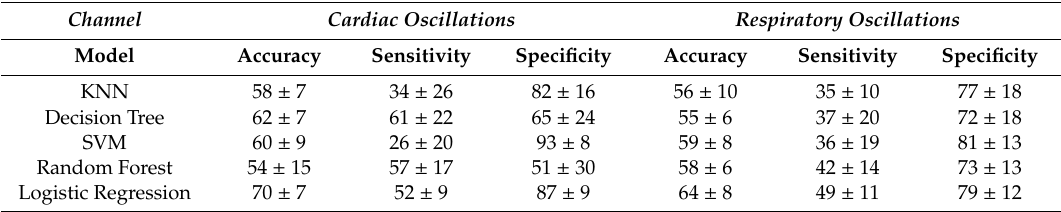
Table 2. Results of Accuracy and Specificity in % for each classifier for blood perfusion rhythmic